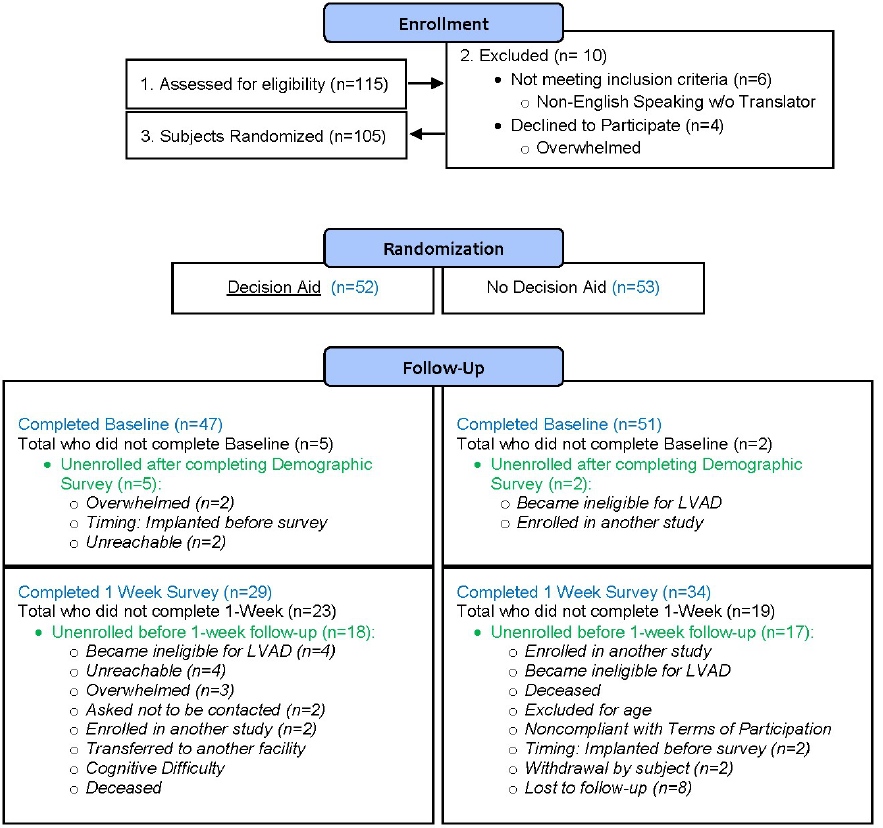
Figure 1. Participant flow chart for the LVAD Decision Aid Trial.